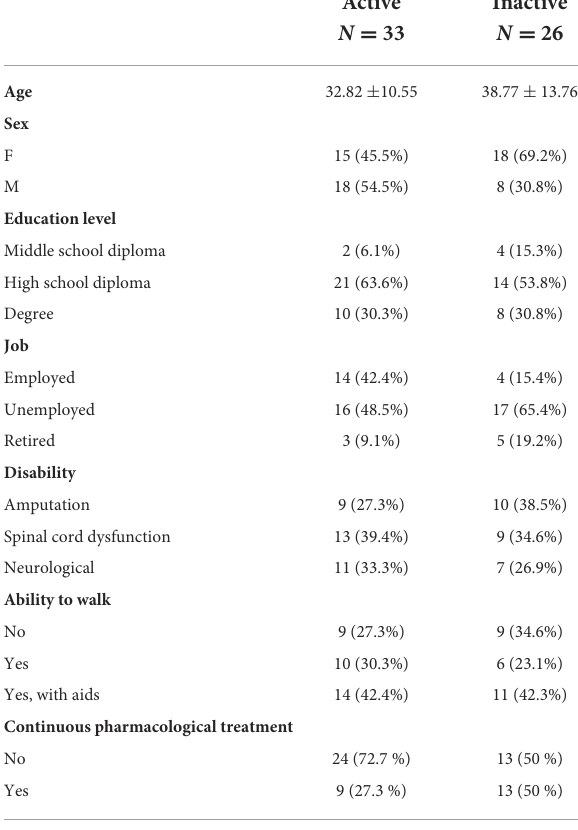
TABLE 1 Demographic